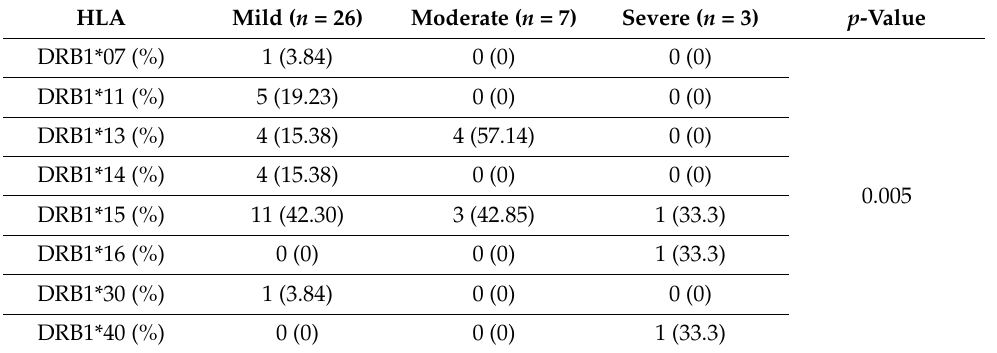
Table 5. HLA association with severity of COVID-19